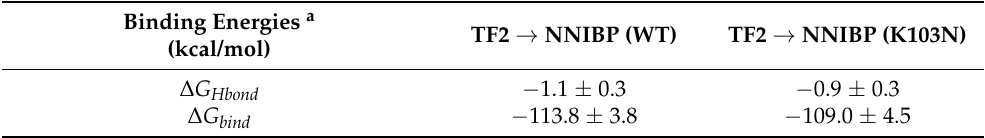
Figure 6. Final complexes of ( A )WT RT- TF2 , ( B ) K103N RT— TF2 obtained from MD simulations. Selected residues are highlighted as pale green lines (carbon atoms in green), the ligand is shown as light pink (carbon atoms) sticks (WT) and light blue (carbon atoms) sticks (K103N), and the primer grip region is colored in pale cyan. ( C ) Superposition of MD structure of the WT RT- TF2 and K103N RT— TF2 . Table 5. MM/GBSA energy calculations.